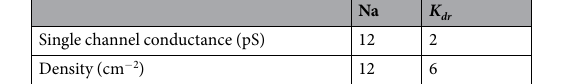
Table 2. Single channel conductances and densities for the stochastic